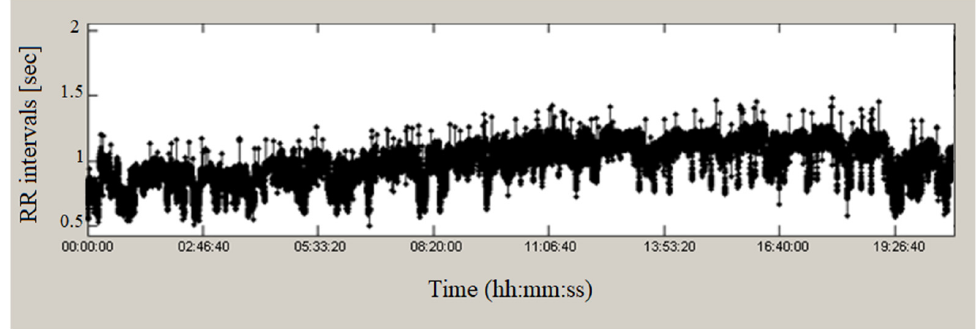
Figure 6. RR intervals, tachycardia.